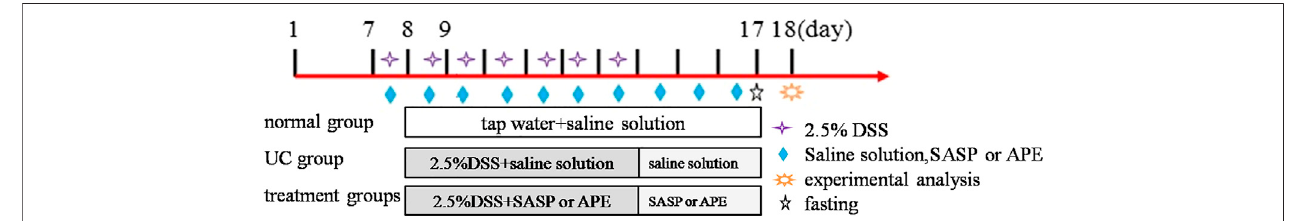
FIGURE 1 | The experimental design. 1 – 7 days are adaptive feeding stage, 8 – 17 days are experimental stage.